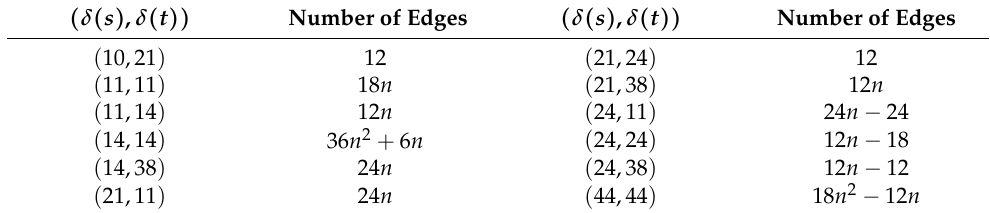
Table 6. Edge partition based on sum of degrees for BHPOH(n).